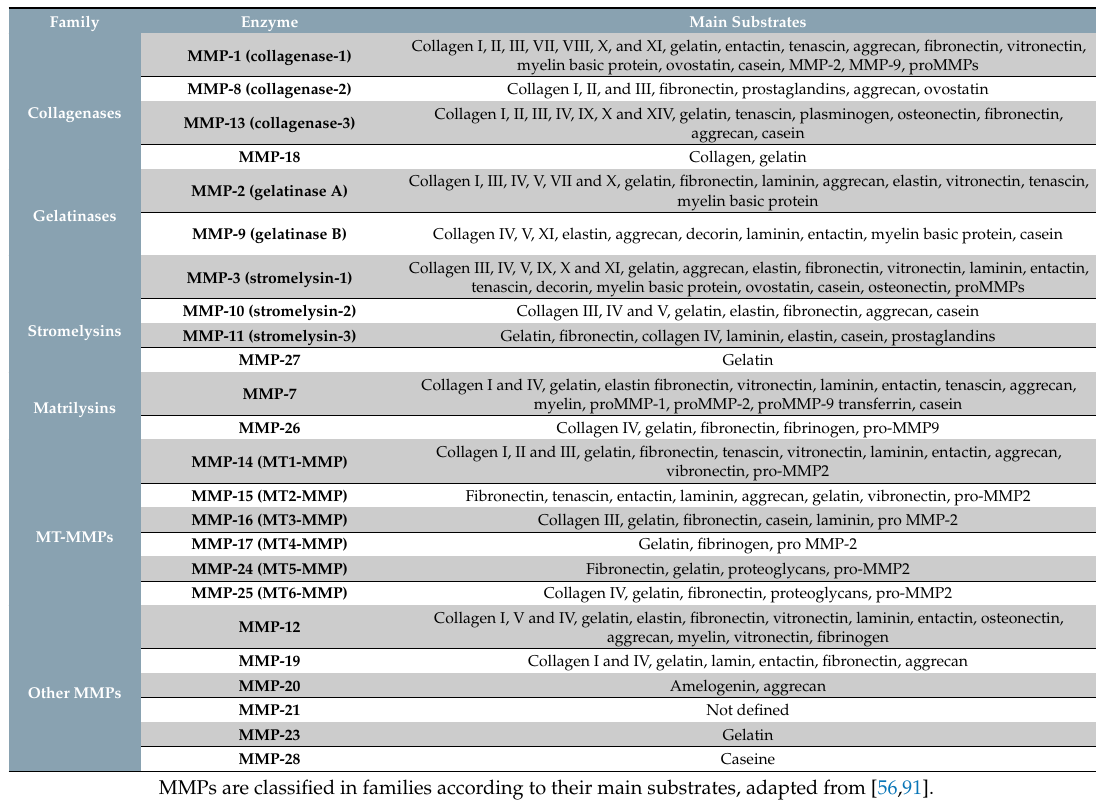
Table 1. Classification of human matrix metalloproteinases